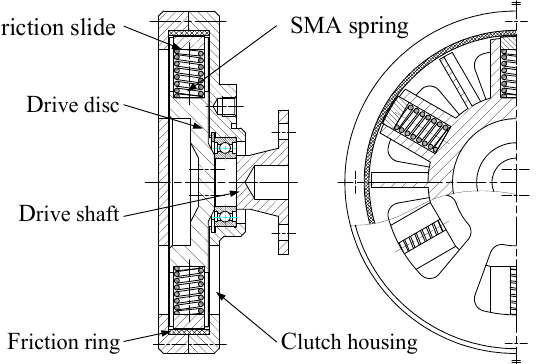
Figure 1. Schematic diagram of adaptive SMA fan clutch.